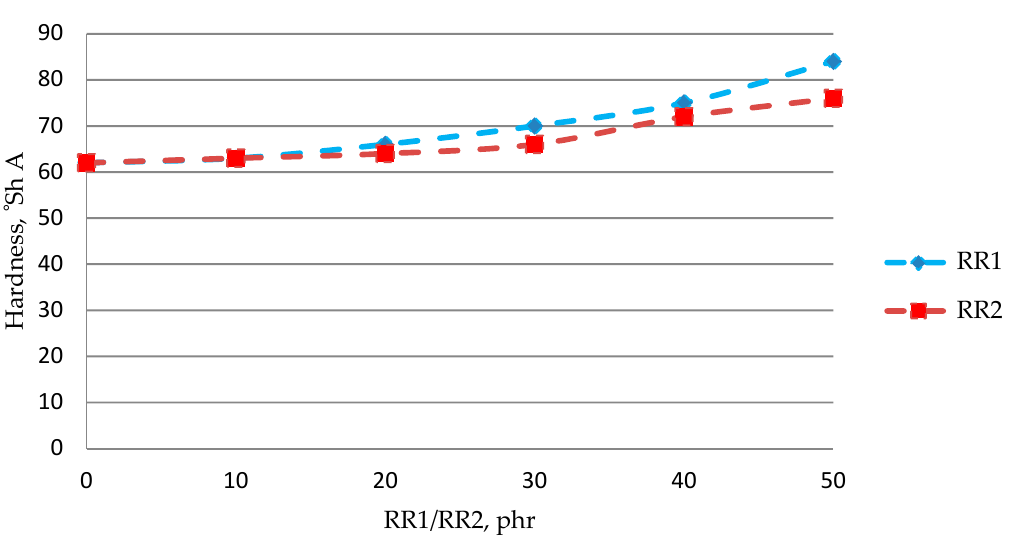
Figure 7. Evolution of hardness according to the percentage of reclaimed rubber used to make the samples.